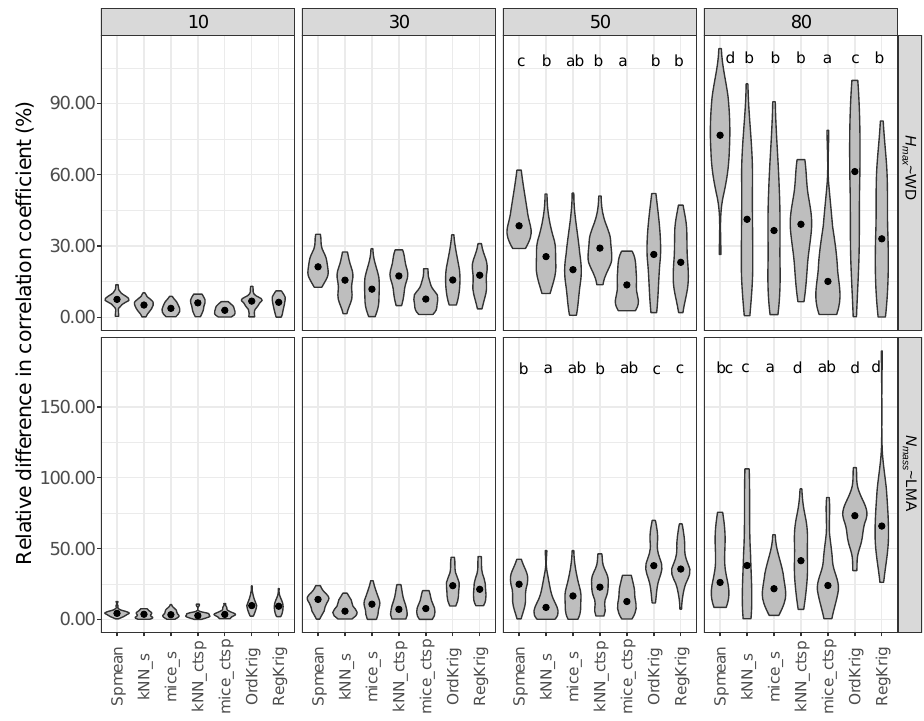
Figure 7. Errors in the correlation coefficient for two selected trait relationships at increasing missingness levels (10–80%) and for different imputation methods: species mean (Spmean); mice and kNN with species as predictor (mice_s and kNN_s, respectively); mice and kNN with species, climate, forest structure and spatial variables as predictors (mice_ctsp and kNN_ctsp, respectively); ordinary kriging (OrdKrig); and regression kriging (RegKrig). Letters denote results of multiple comparisons, in alphabetical order from highest to lowest